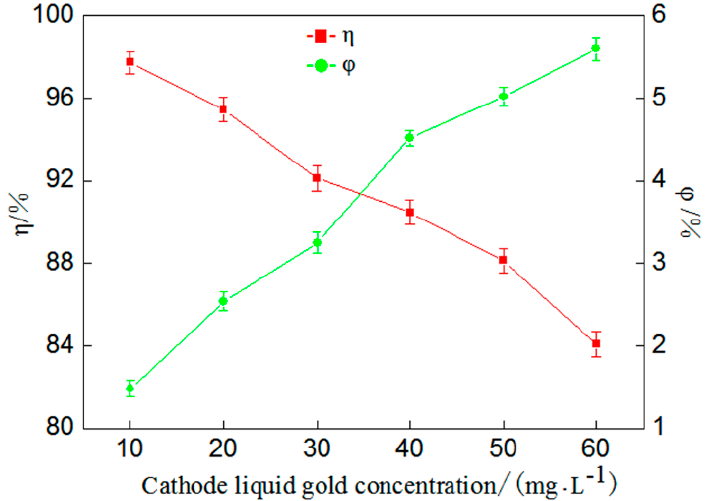
Figure 1. Influence of gold concentration in catholyte on percentage of gold deposition ( η ) and coulombic efficiency ( φ ).